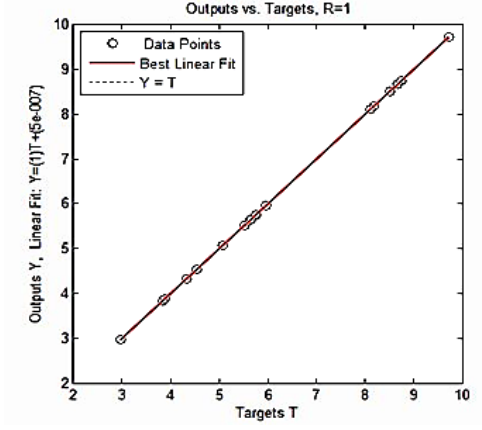
Figure 13. Regression plot of actual and network’s R a .